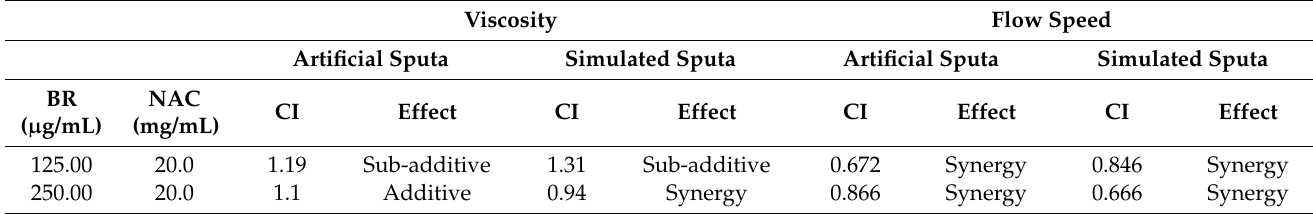
The combination index when NAC (2.0%) is combined with either bromelain at 125 or 250 µ g/mL (BromAc) in both viscosity and flow speed measurement as determined by the Chou and Talalay method for artificial and simulated